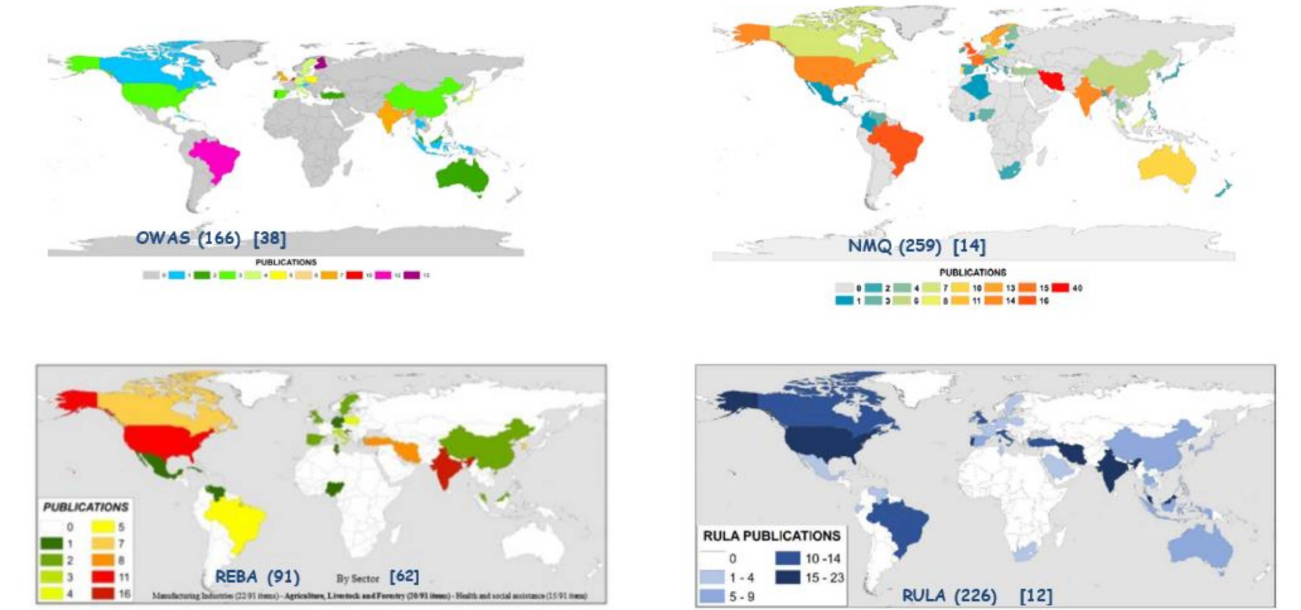
Figure 3. Use of the most significant methods [12,14,38,62].